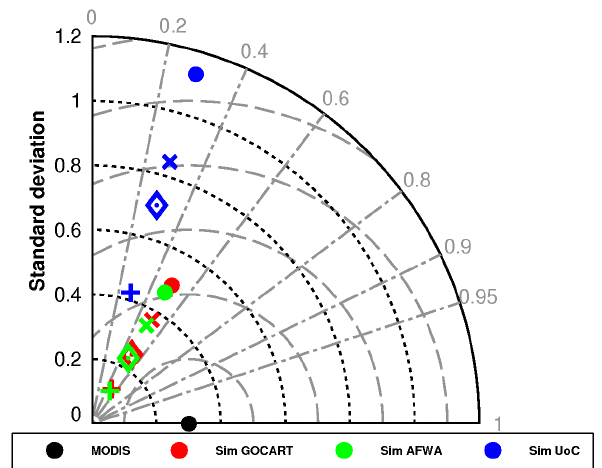
Figure 4. Taylor diagram comparing the 6-month AOD average of all simulations with MODIS observations for the region illus- trated in Fig. 2. Root mean square error lines (grey-dashed cir- cular lines) and SDs (blacked dotted lines) are plotted with an interval of 0.2, while correlation coefficients are shown by the grey radii lines. Symbols in red stand for Sims_GOCART, in green for Sims_AFWA and in blue for Sims_UoC. The black dot stands for MODIS, dots (.) for Sim_GOCART-1, Sim_AFWA- 1 and Sim_UoC-2, (X) for Sim_GOCART-0.75, Sim_AFWA- 0.75 and Sim_UoC-1.5, Diamond ( ) for Sim_GOCART-0.5, Sim_AFWA-0.5 and Sim_UoC-1, cross ( + ) for Sim_GOCART- (cid:51) 0.25, Sim_AFWA-0.25 and